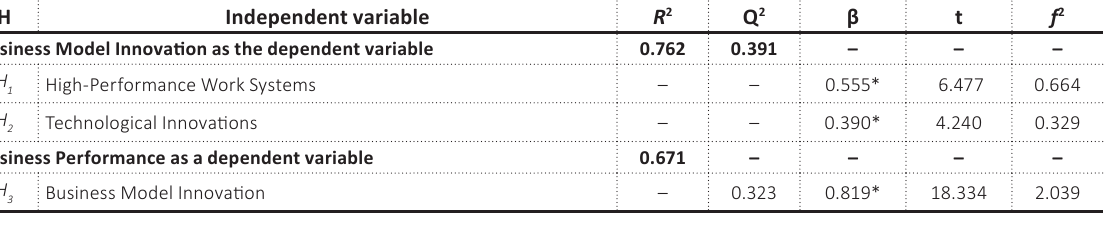
Table 6. Direct effects in the path analysis ( n = 70 ) H